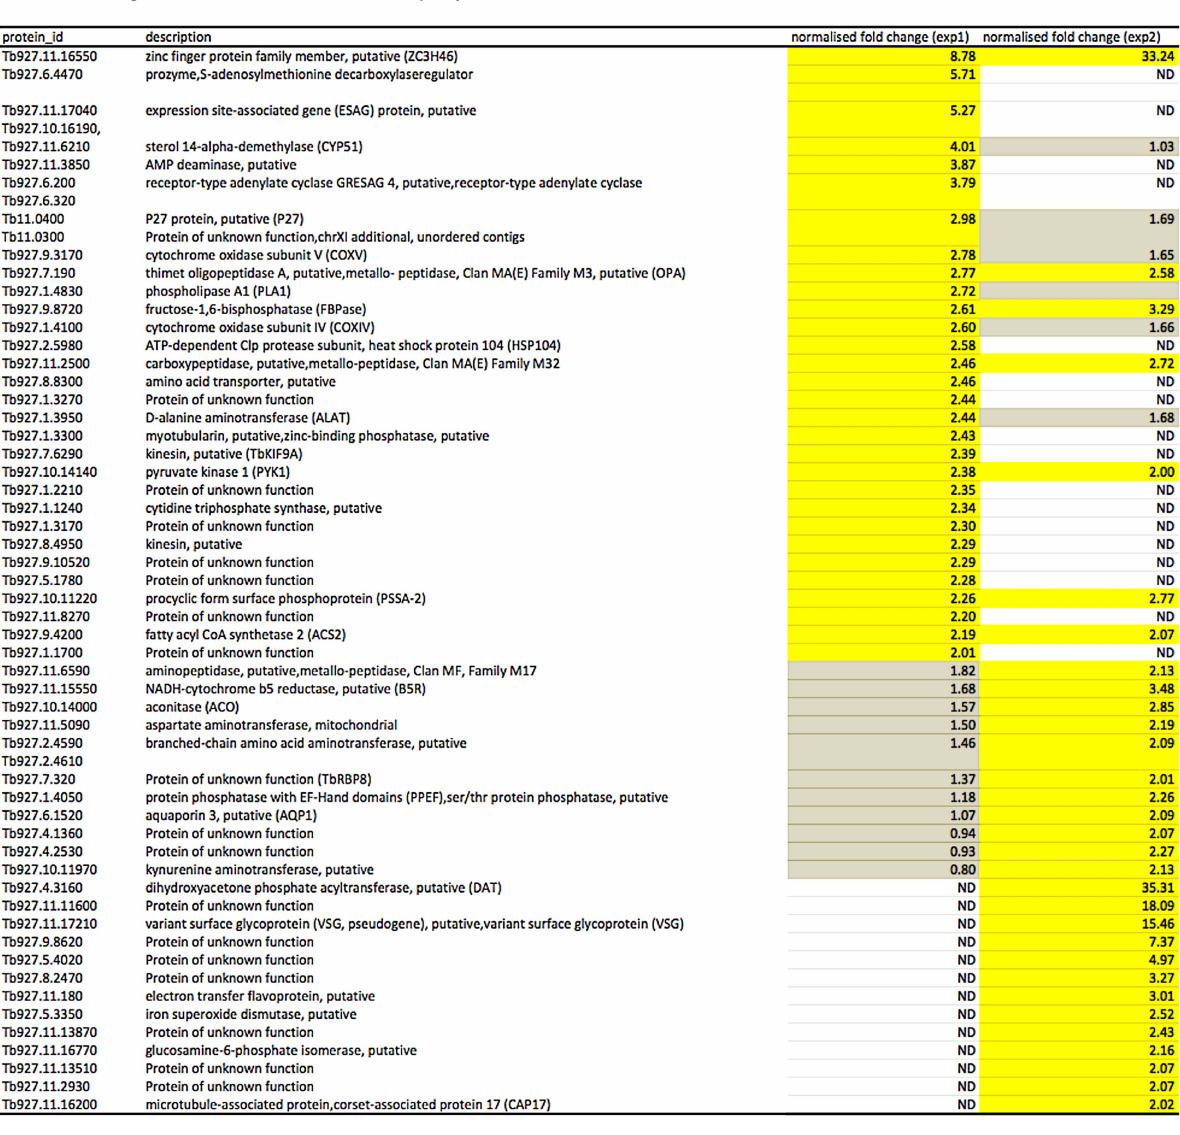
Figure 5. Proteins up-regulated in late procyclic forms. Yellow: proteins showing $ 2-fold increase in abundance. Grey: # 2-fold change in abundance. N.D. not detected. Biological replicates (exp1 and exp2) were performed. show normal colonisation of the midgut, but defects in colonisation of the salivary glands [6,25,26] are SoMo-positive as early procyclic forms. While it might be argued that these mutants have other defects, such as an inability to penetrate the proventriculus or to differentiate to epimastigote forms, in no case does the mutation impair SoMo by early procyclic forms. Social interactions between bacteria are known to involve outer membrane proteins [27]. Despite being the major surface glyco- proteins of procyclic forms, and present in several million copies, neither GPEET nor EP procyclin is required by trypanosomes for SoMo. It is known, however, that procyclin null mutants export free GPI anchors to their surface [28], and these might compensate for the loss of procyclins. The insect-stage specific transmembrane protein PSSA-2 [26], which shows increased expression in late procyclic forms (Table 2), is also dispensable for SoMo.